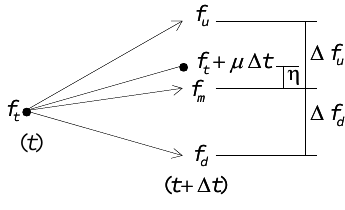
Fig. 1 Trinomial evolution of the stochastic